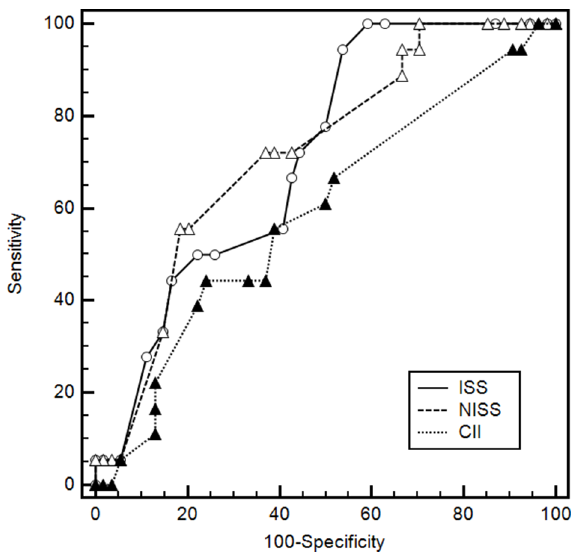
Figure 1. Receiver operating characteristic (ROC) curves of different trauma scoring systems for predicting respiratory failure in patients admitted to our hospital in the Lushan earthquake. The solid line indicates the ROC curve for the Injury Severity Score (ISS); the dashed line, the curve for the New Injury Severity Score (NISS); and the dotted line, the curve for the Chest